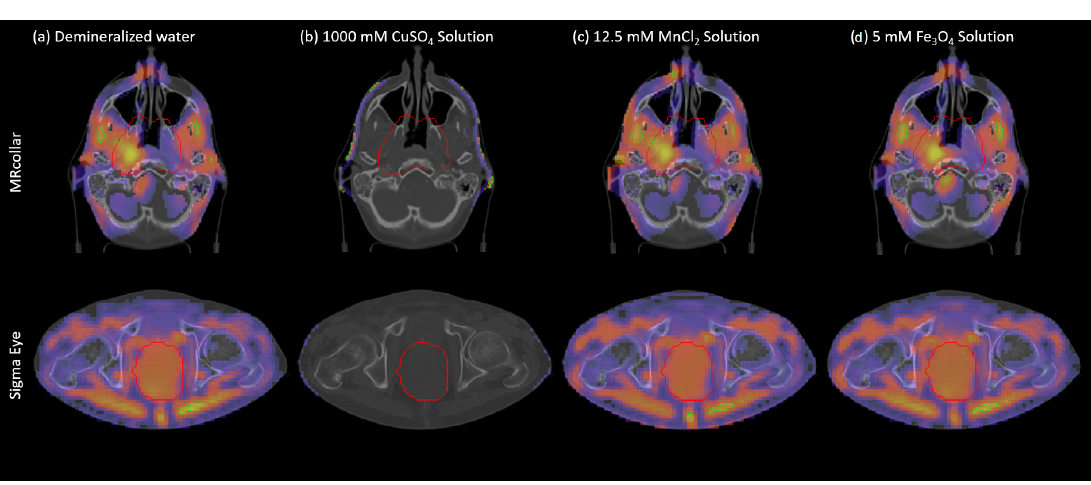
Figure 3. Predicted SAR distributions for models of patients treated with head and neck (MRcollar) and deep pelvis (Sigma Eye) hyperthermia when the WB is filled with ( a ) demineralized water, ( b ) 1000 mM CuSO 4 solution, ( c ) 12.5 mM MnCl 2 solution, and ( d ) 5 mM Fe 3 O 4